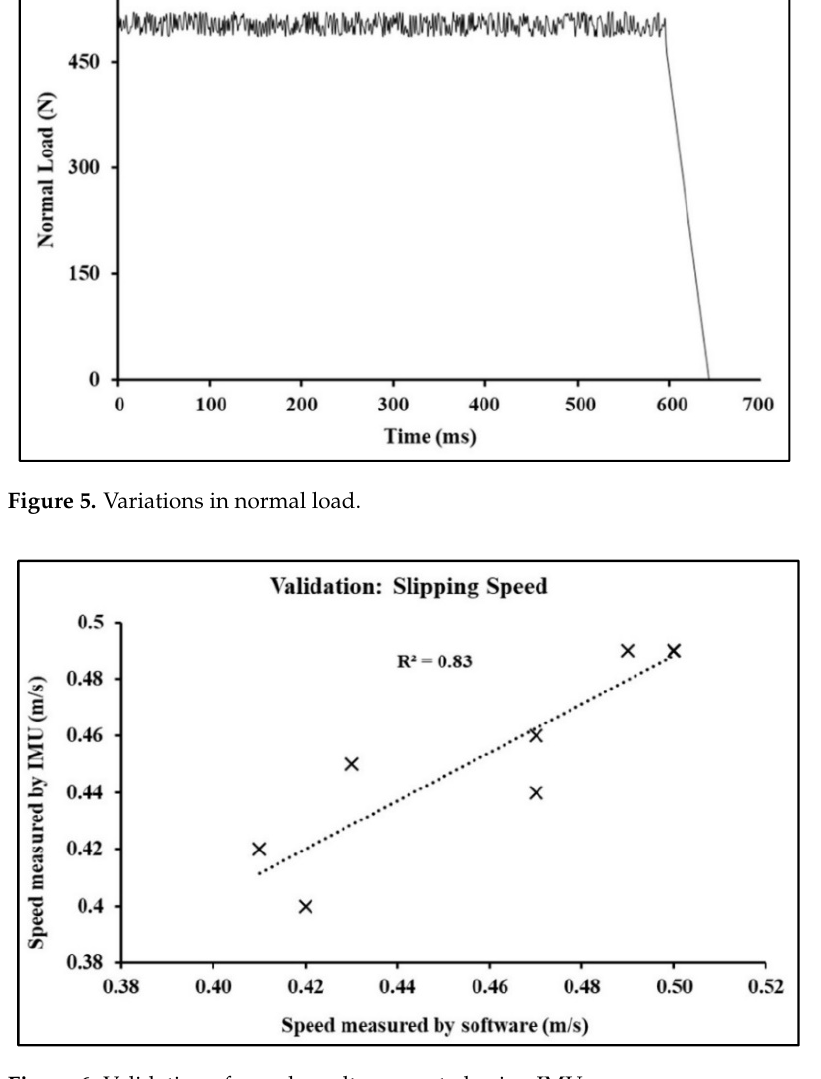
Figure 6. Validation of speed results generated using IMU.